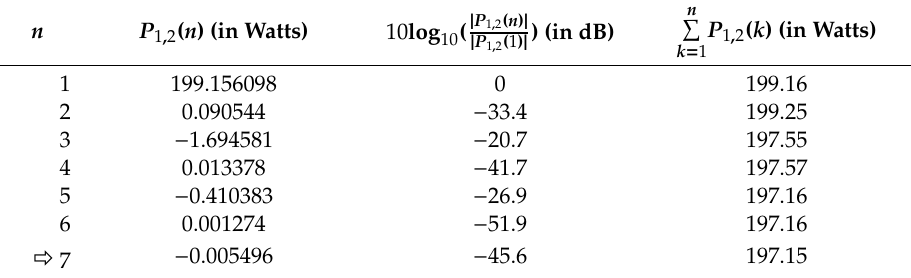
Table 4. Estimation of P 1,2 , the power transferred over the air-gap. 𝒏